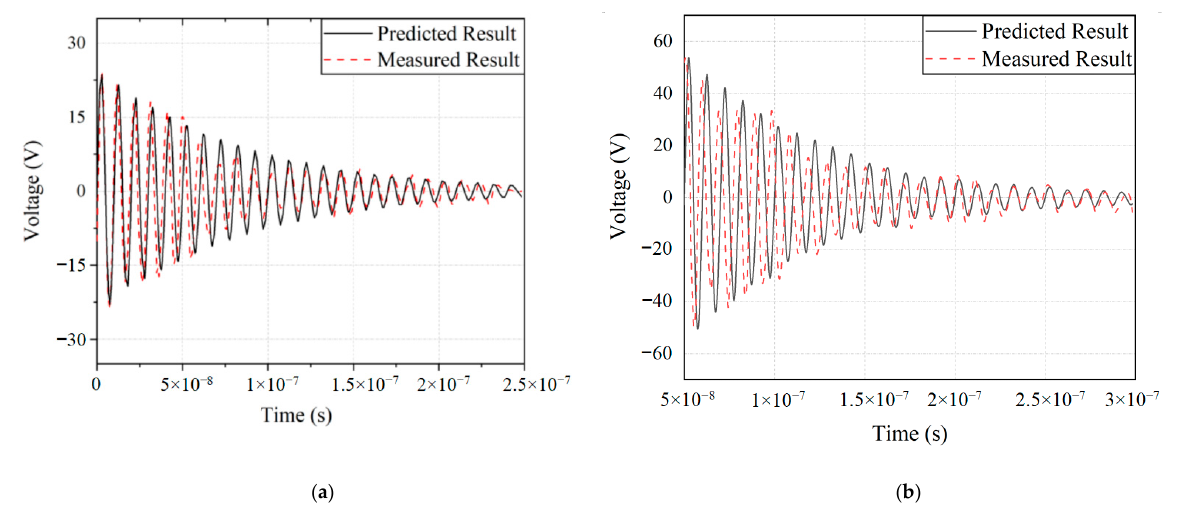
Figure 10. Comparison of numerical and measured curves.